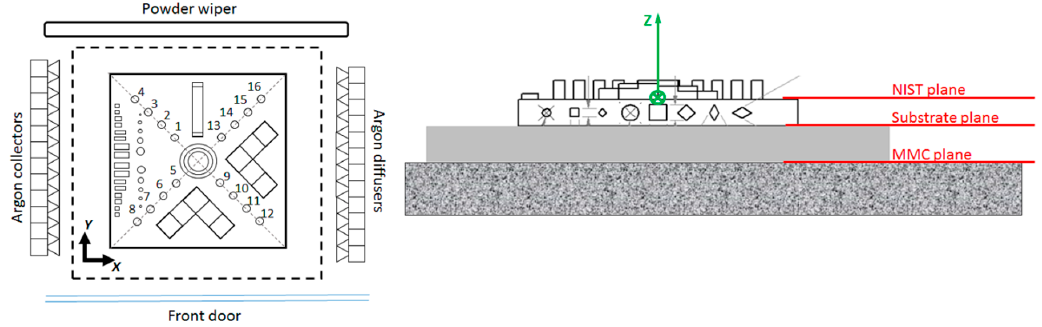
Figure 3. SLM workpiece orientation and CMM configurations and used to analyze the geometrical distortions of the SLMed NIST part in Inconel 718 alloy.